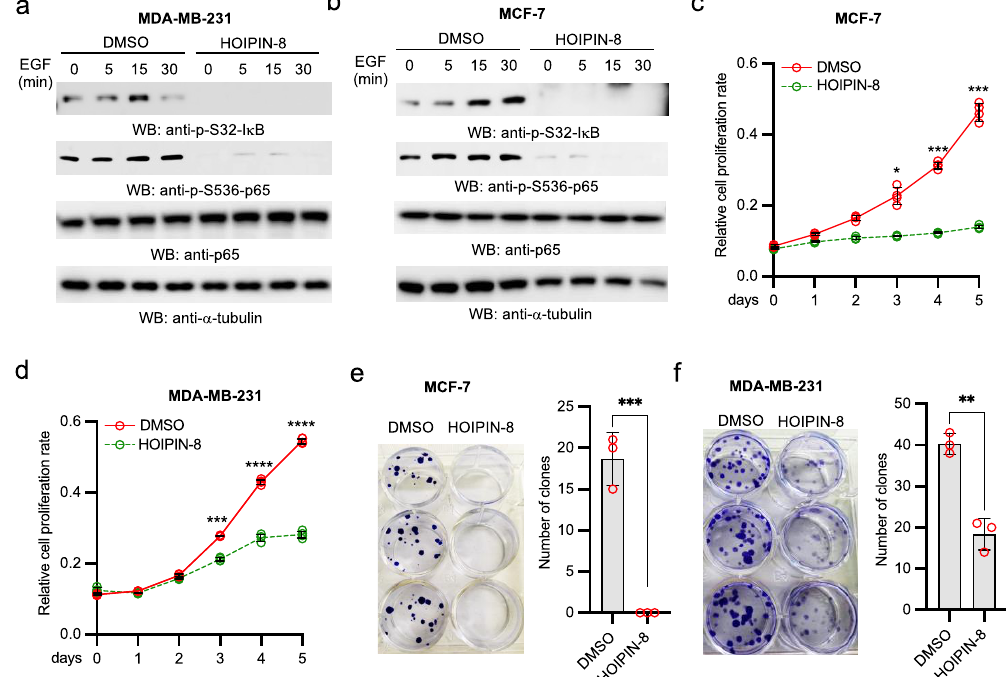
Figure 7. HOIPIN-8 impairs EGFR-mediated NF- κ B activation in breast cancer cells and inhibits their proliferation and clonogenicity. ( a ) MDA-MB-231 cells were treated with DMSO or 30 μ M HOIPIN-8 for 2 h. Then, cells were stimulated with 5 ng/mL EGF for designated times. Cell lysates were blotted as indicated. ( b ) MCF-7 cells were treated with DMSO or 30 μ M HOIPIN-8 for 2 h. Then, cells were stimulated with 5 ng/mL EGF for designated times. Cell lysates were blotted as indicated. ( c , d ) MCF-7 ( c ) and MDA-MB-231 ( d ) cells treated with DMSO or 30 μ M HOIPIN-8. Cells were collected